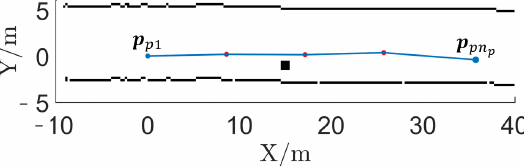
Figure 6. An example of P S . Algorithm 2. Path simplification